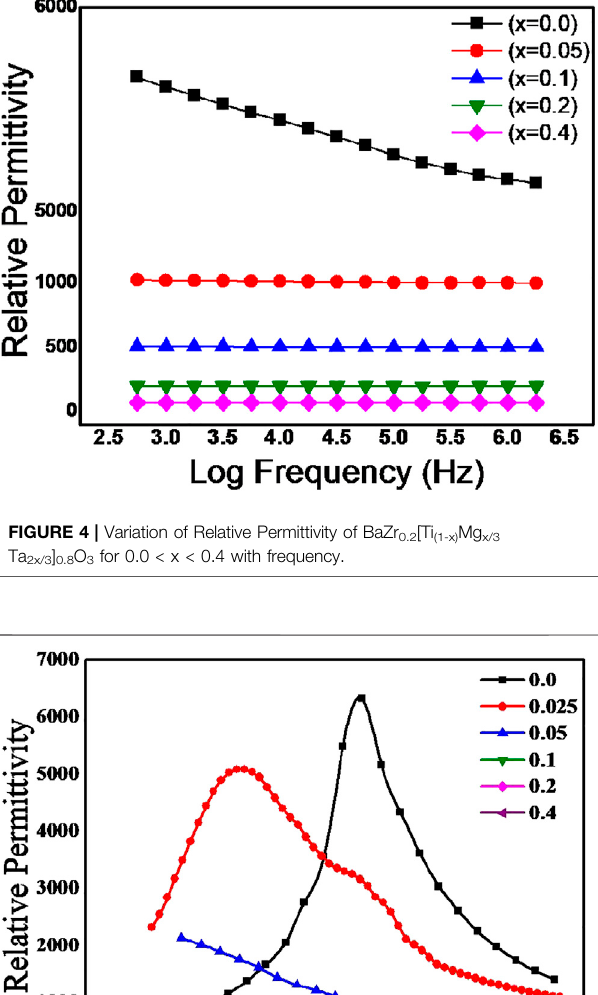
(cid:1) 0), the relative permittivity Figure 5 . In BaZr 0.2 Ti 0.8 O 3 (x